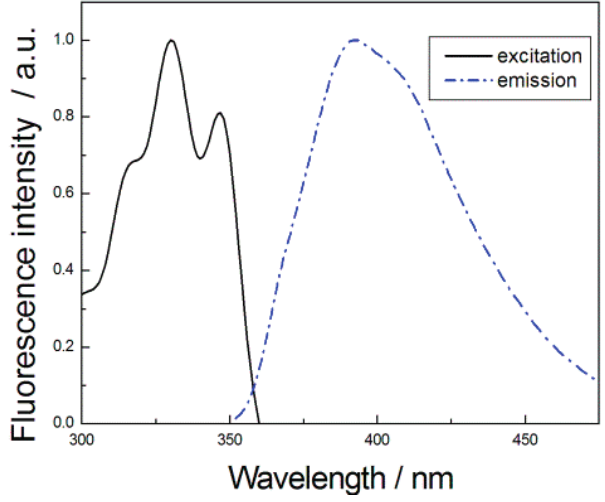
Figure 1. Normalized excitation and emission spectra of S -G1 ( λ ex = 330 nm, λ em = 392